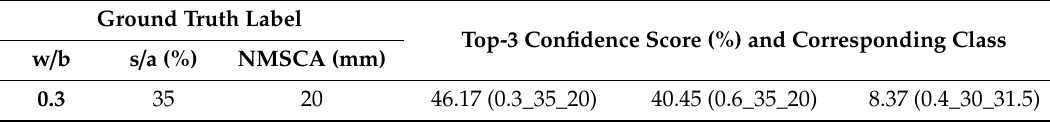
Table 14. Testing images which Net-II returned low confidence score of ground truth label being the proper